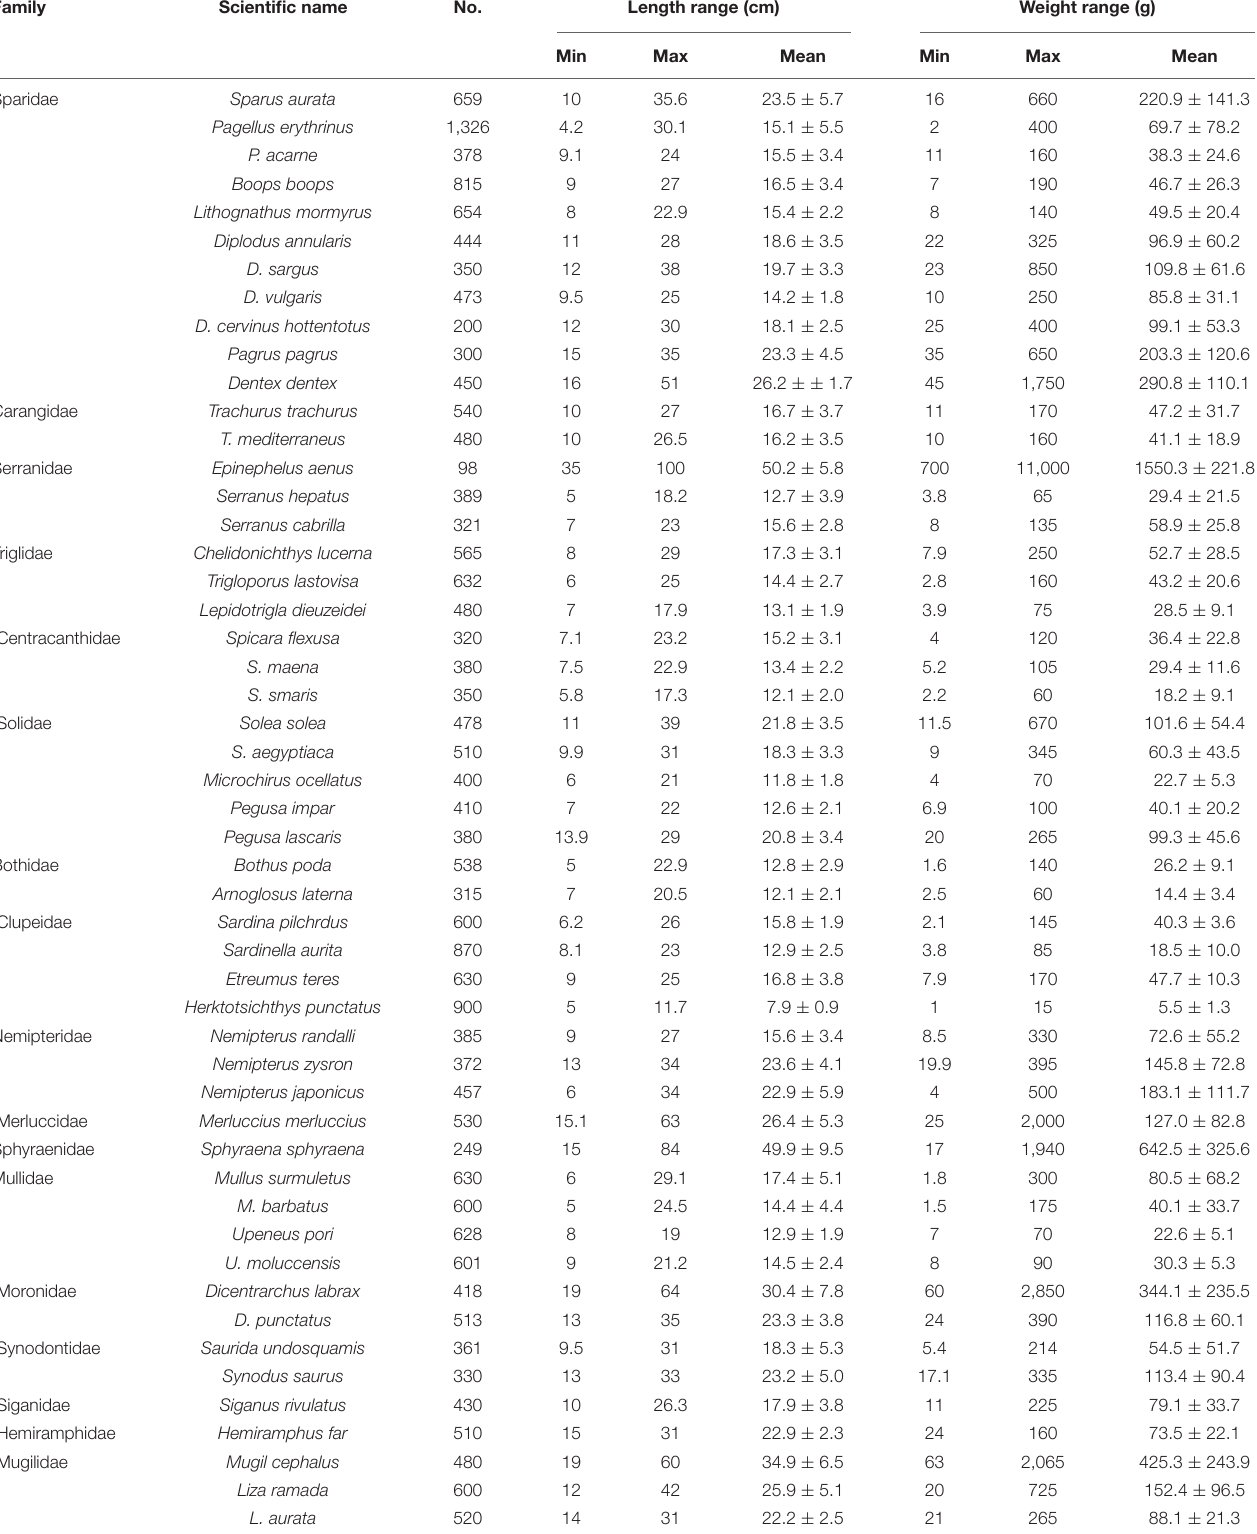
TABLE 1 | Common fish species in the GSA 26, including family name, the scientific name of species, total number, length and weight range, and the mean ± SD.